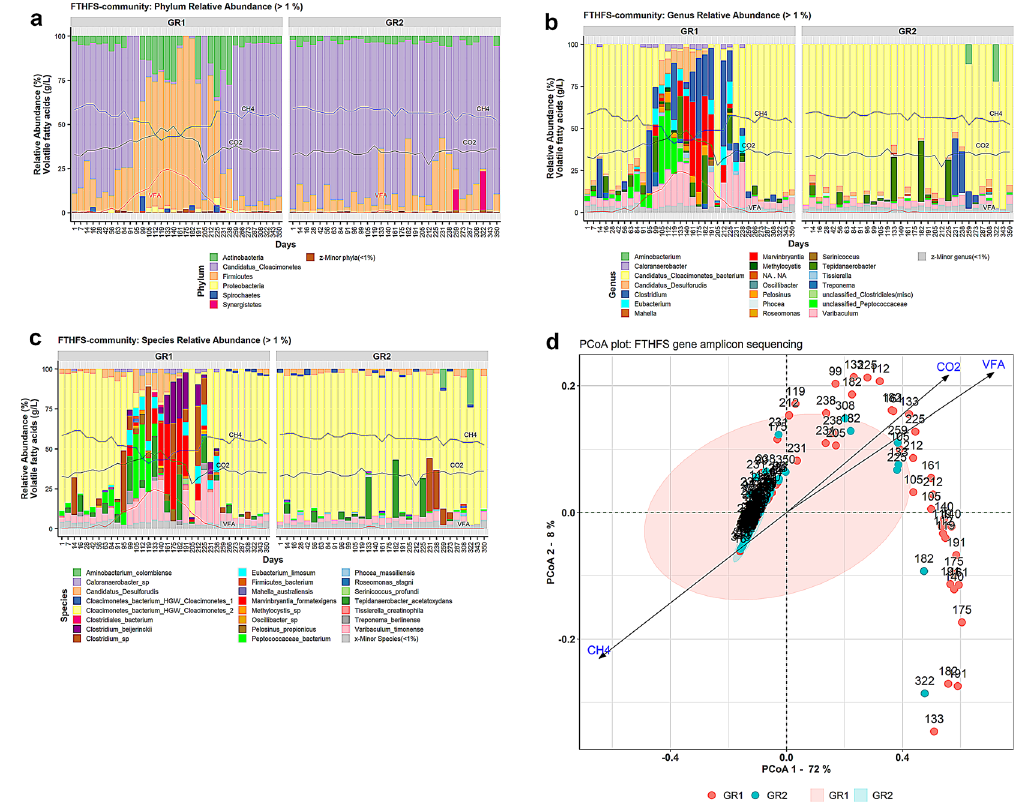
Figure 4. Plots of acetogenic community based on FTHFS gene amplicons in experimental reactor GR1 and control reactor GR2 at ( a ) phylum level (relative abundance (RA) > 1%), ( b ) genus level (RA > 1%) and ( c ) species level (RA > 1%). VFA, CH 4 and CO 2 represent the level of total volatile fatty acids (g/L), methane content (%) and carbon dioxide content (%), respectively. ( d ) Principal coordinate analysis (PCoA) plot with weighted UniFrac distance matrix visualising beta diversity of the potential acetogenic community inferred from FTHFS gene sequencing in samples from reactors GR1 and GR2 under the influence of environmental parameters carbon dioxide content (%), total VFA (g/L) and methane content